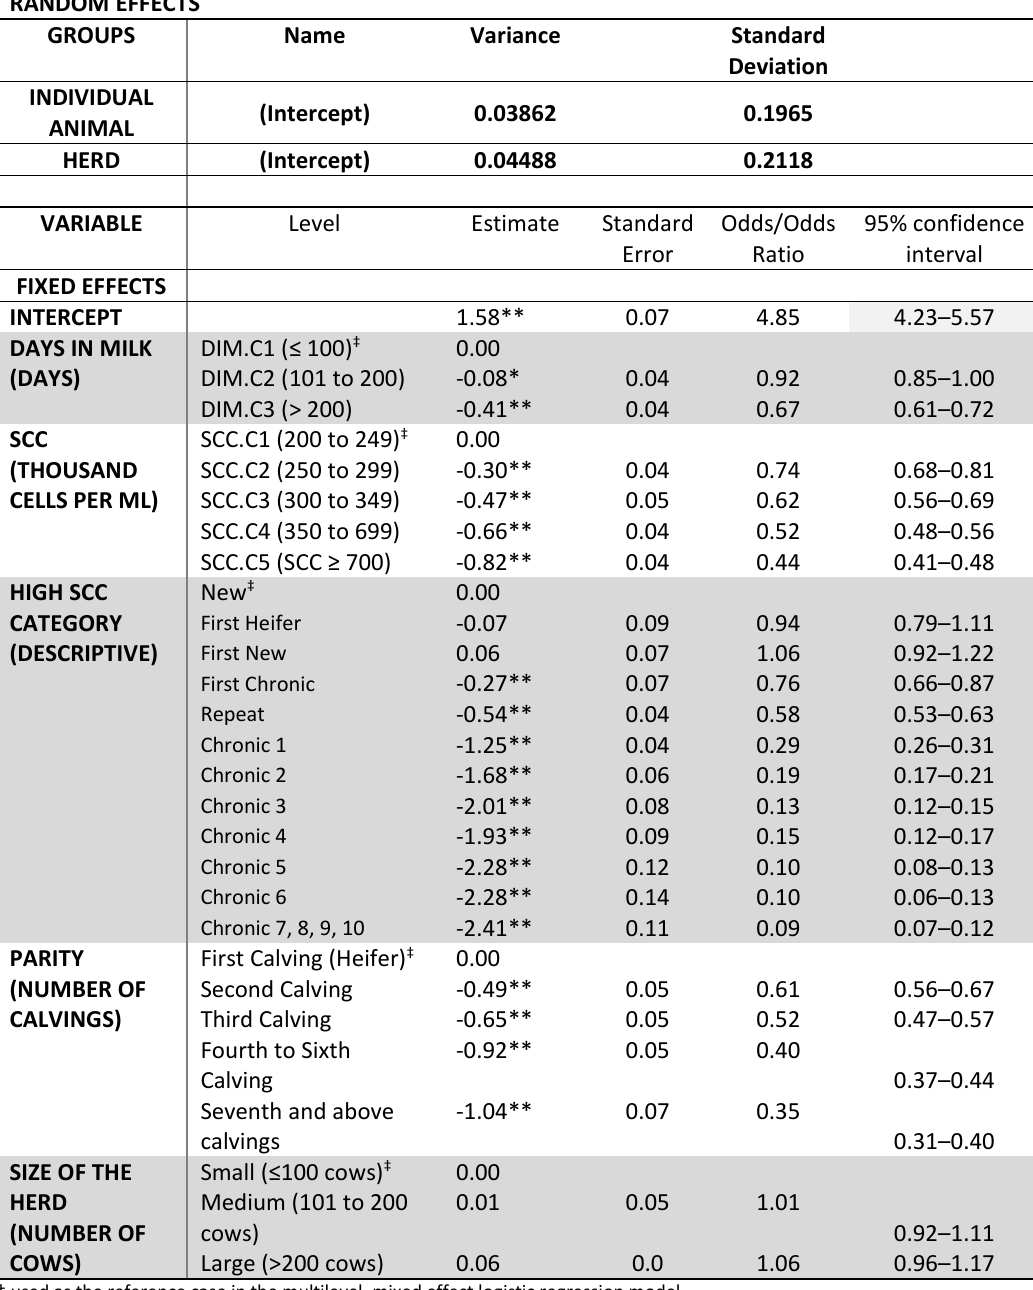
Table 3: Summary of the multilevel, mixed effect logistic regression The results of the model provide information on both the random as well as the fixed effects within the sample. The different measurements and hence recovery probabilities are considered for each individual animal which is also clustered within different herds. According to the outcome of the model, small variability is observed amongst the individual animals (0.0386) and the same can be concluded for the variability amongst the different herds